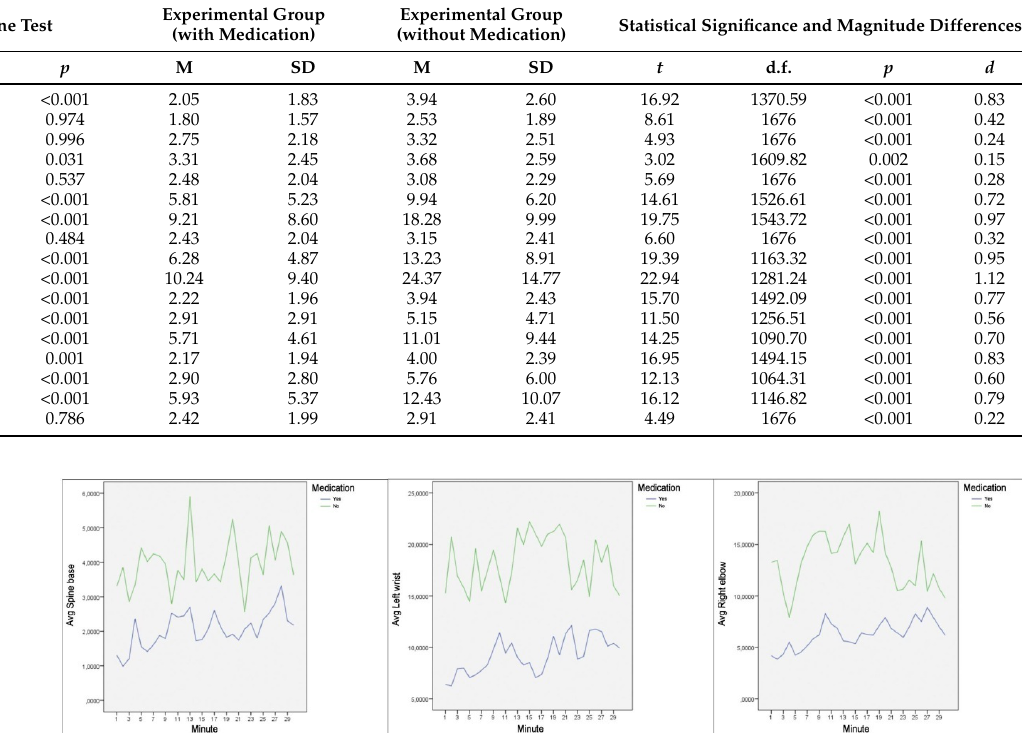
Table 4. Differences in means of movement of the different joints recorded by Kinect between the experimental group with and without taking their usual medication.